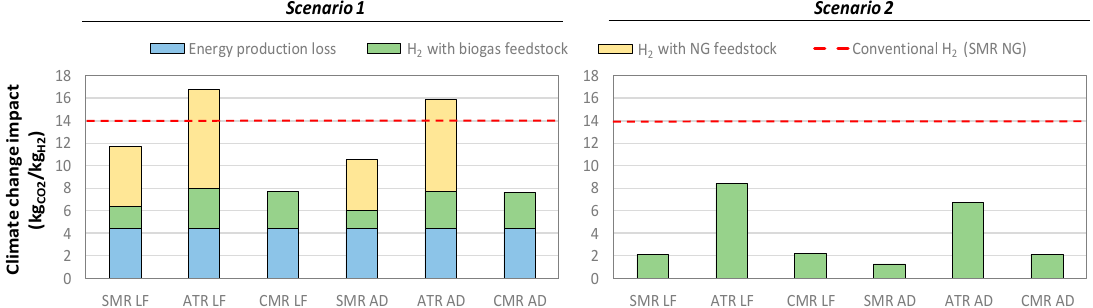
Figure 6. Climate change impact of the investigated systems against the conventional H 2 production from natural gas steam reforming.